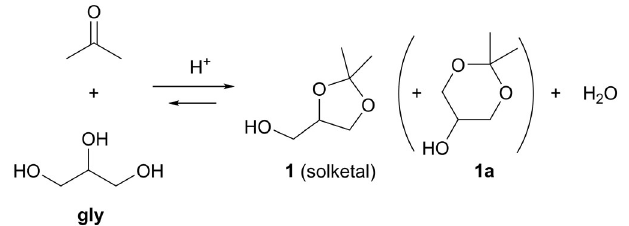
Figure 2. solketal preparation through acetalization of gly